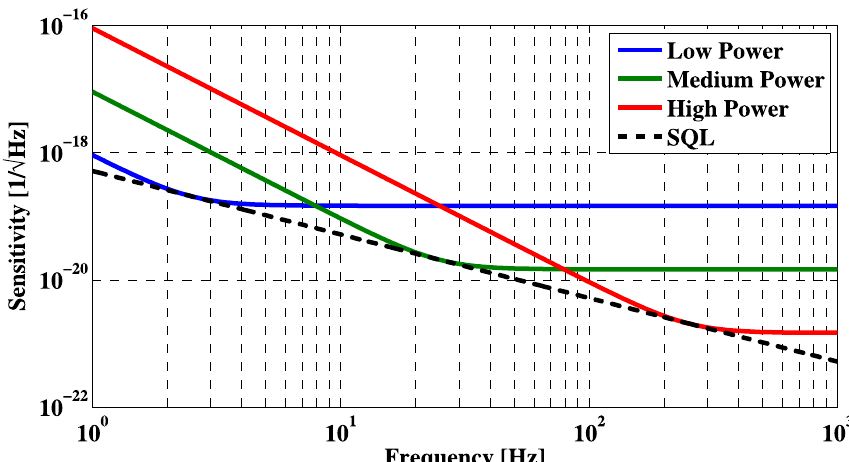
Fig. 2 Quantum noise levels of a toy model, giving AdLIGO test mass (40kg) with 1000 W(blue), 100 kW(green), and 10 MW(red) incident powers respectively. The shot noise at high frequencies decreases with higher power; however, the radiation pressure noise increases. The black line shows quantum noise, a sum of minimum shot noise, and radiation pressure noise, over different laser powers, which forms a boundary of quantum noise called the Standard Quantum Limit